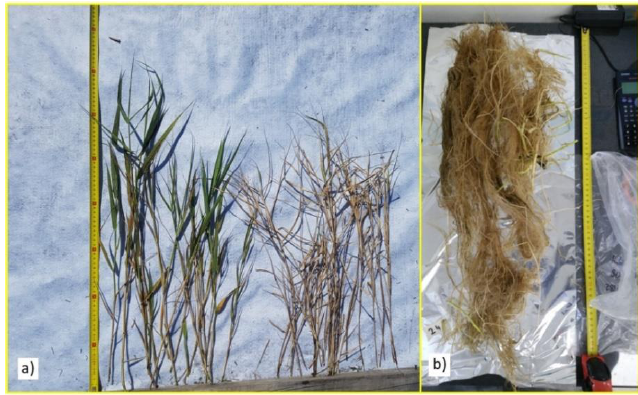
Figure 3. Measurement of Shoots ( a ) and Roots ( b ) of Phragmites australis plants after 12 weeks.